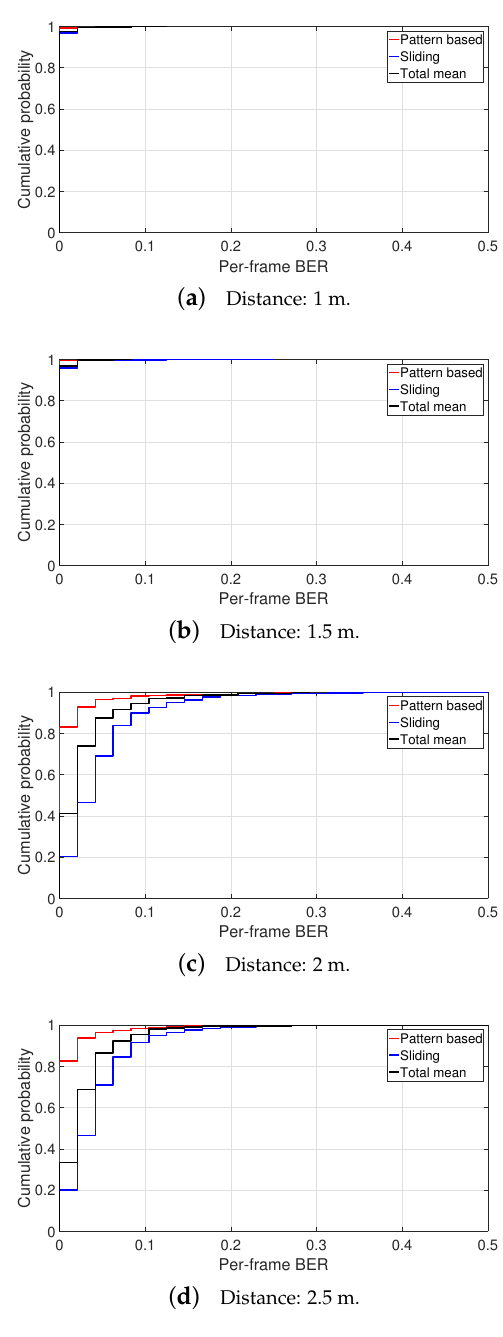
Figure 13. Cumulative probability distribution of per-frame BER for 100